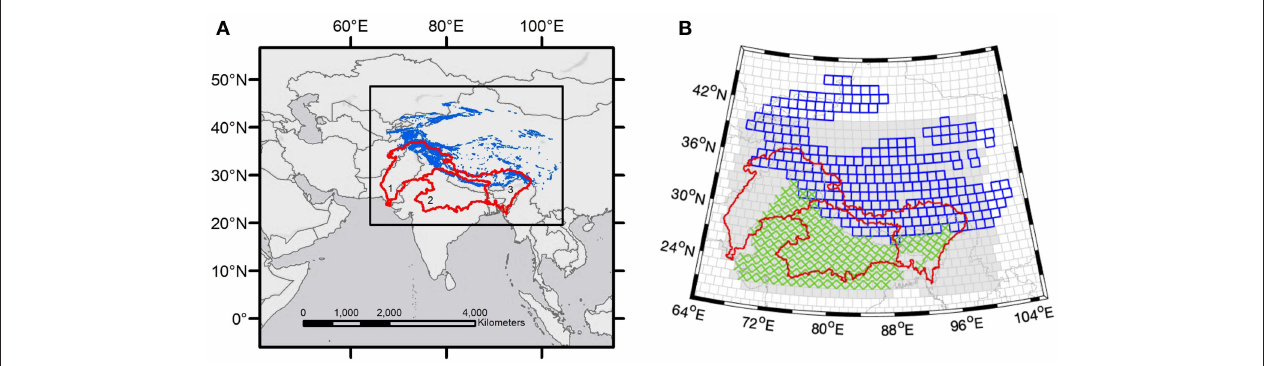
FIGURE 1 | (A) The High Mountain Asia region, including glacier extent from Pfeffer et al. (2014) (blue) and the major basins in the region (red): 1-Indus, 2-Ganges, and 3-Brahmaputra. (B) Zoom-in of the HMA region showing the data distribution of the Land Information System (shaded gray), groundwater measurements (green X’s), and geodetic glacier mass balance observations (blue boxes). The visible cells correspond to the HMA subset of the global 1-arc-degree NASA GSFC mascon